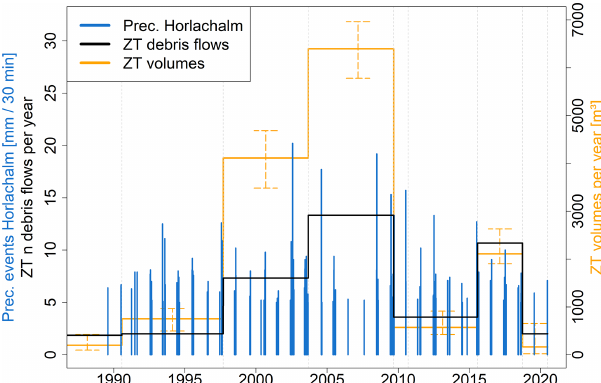
Figure 13. High-intensity rainfall events exceeding 5mm per 30min at the Horlachalm station combined with the number of mapped debris flows per year in ZT (black) and the deposited de- bris flow volumes per year in ZT (orange). The sub-catchment ZT is located quite close to the Horlachalm meteorological